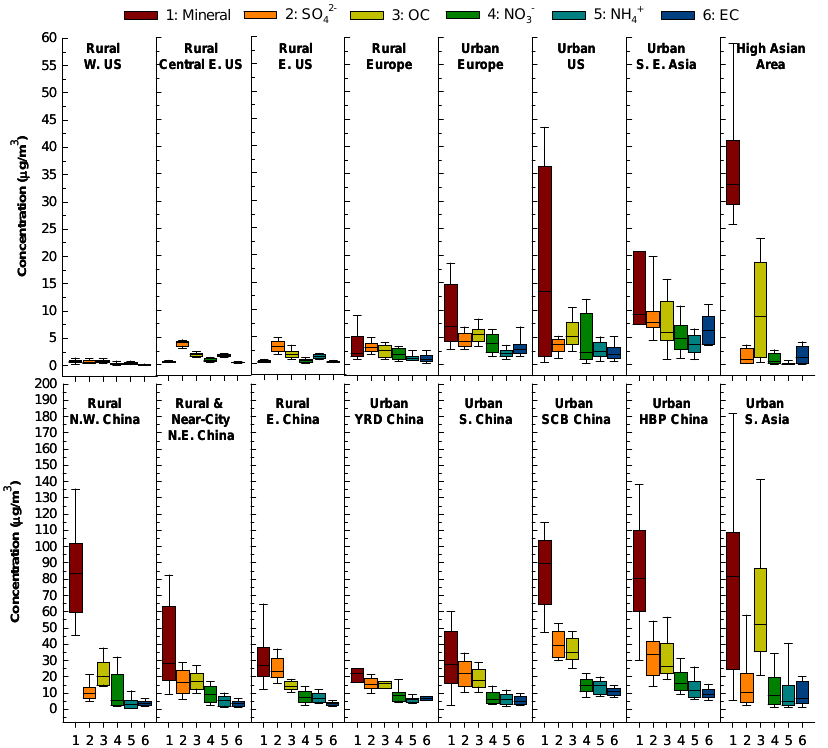
Fig. 4. Box plot summarized the annual, seasonal or monthly mean mass concentration (µgm − 3 ) of six major types of aerosol particles in diameter smaller than 10 micron with at least an entire year data from various rural and urban sites in 16 areas of the world continental